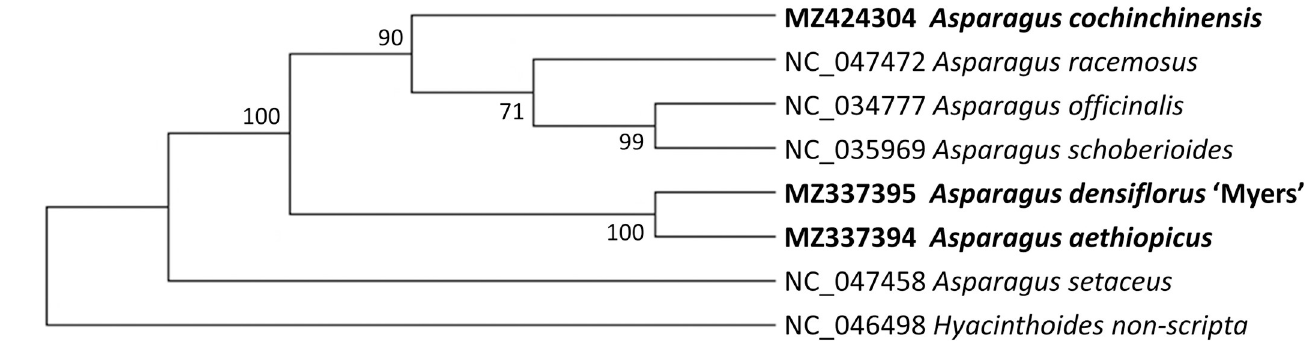
PLOS ONE | https://doi.org/10.1371/journal.pone.0266376 April 25,